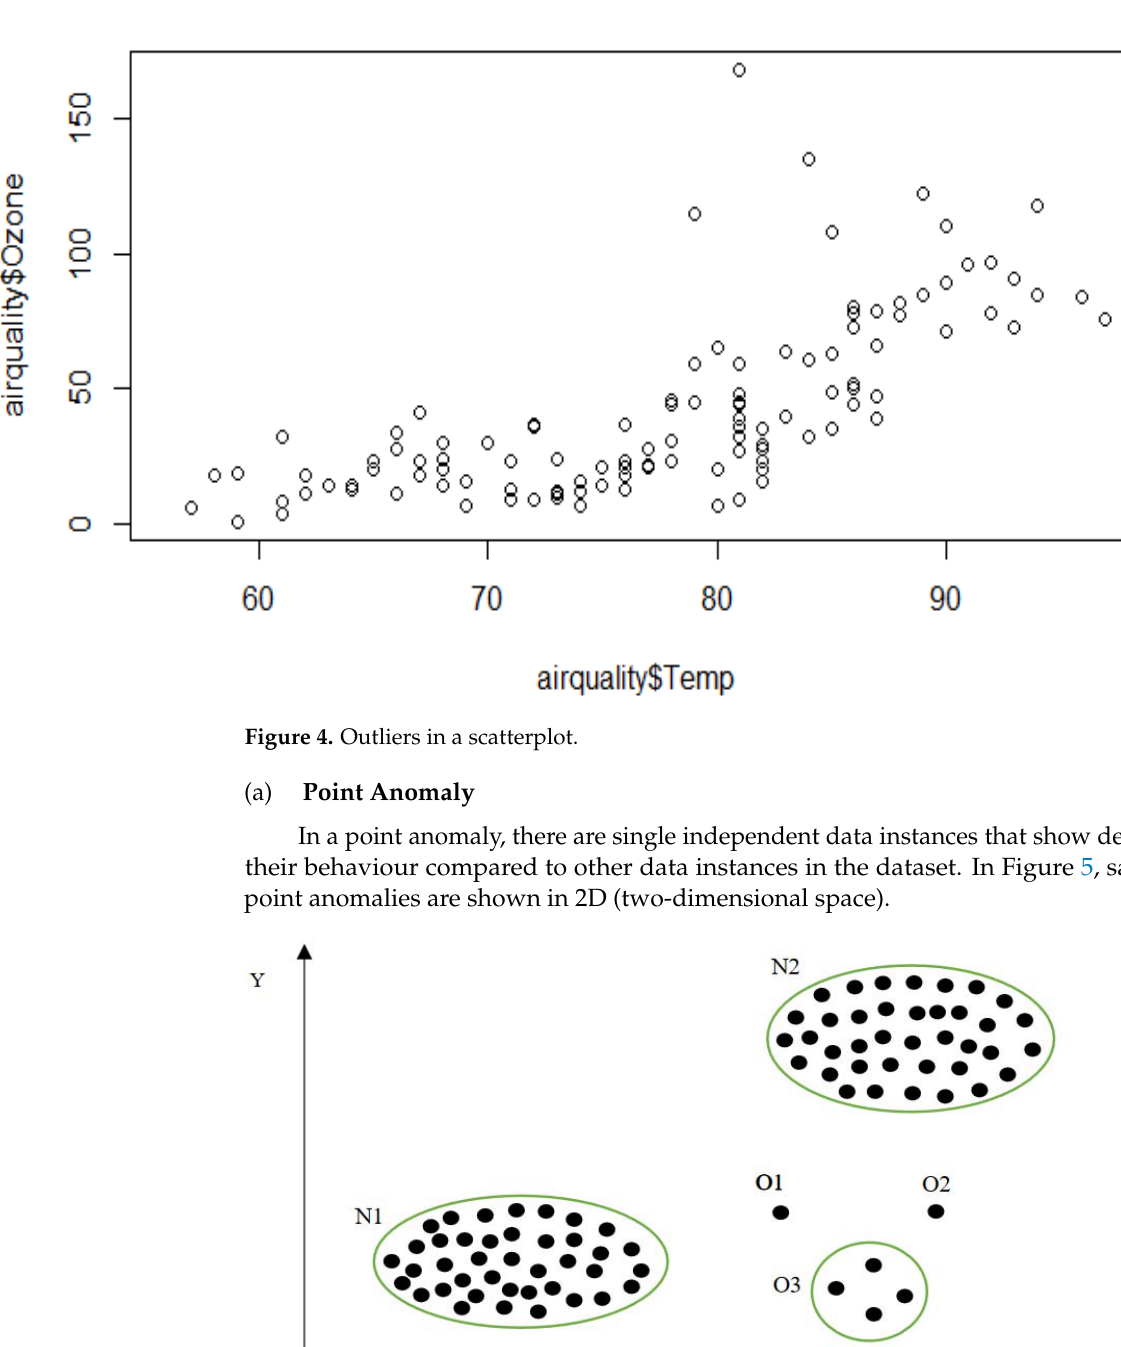
Figure 3. Outliers in a boxplot.